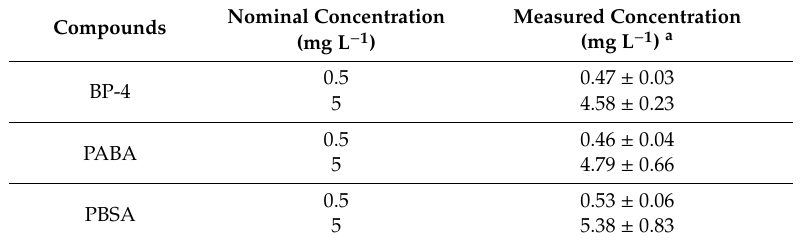
Table 2. Nominal and corresponding measured concentrations of the three